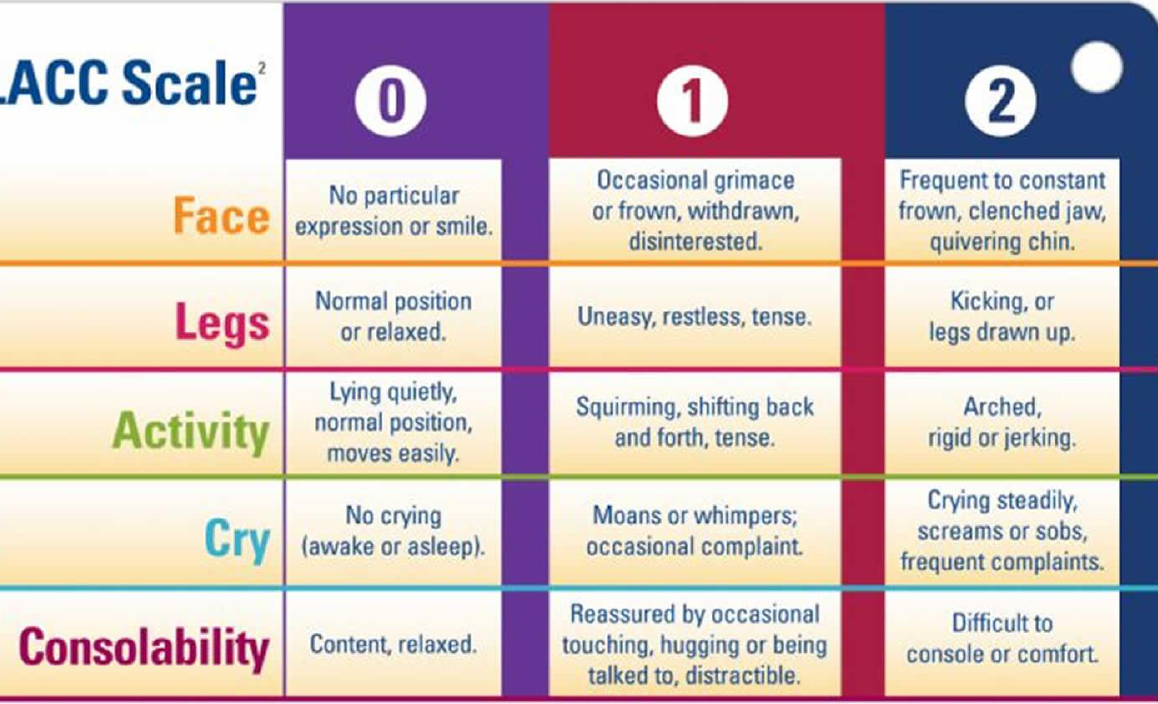
Figure 1. FLACC pain assessment tool.